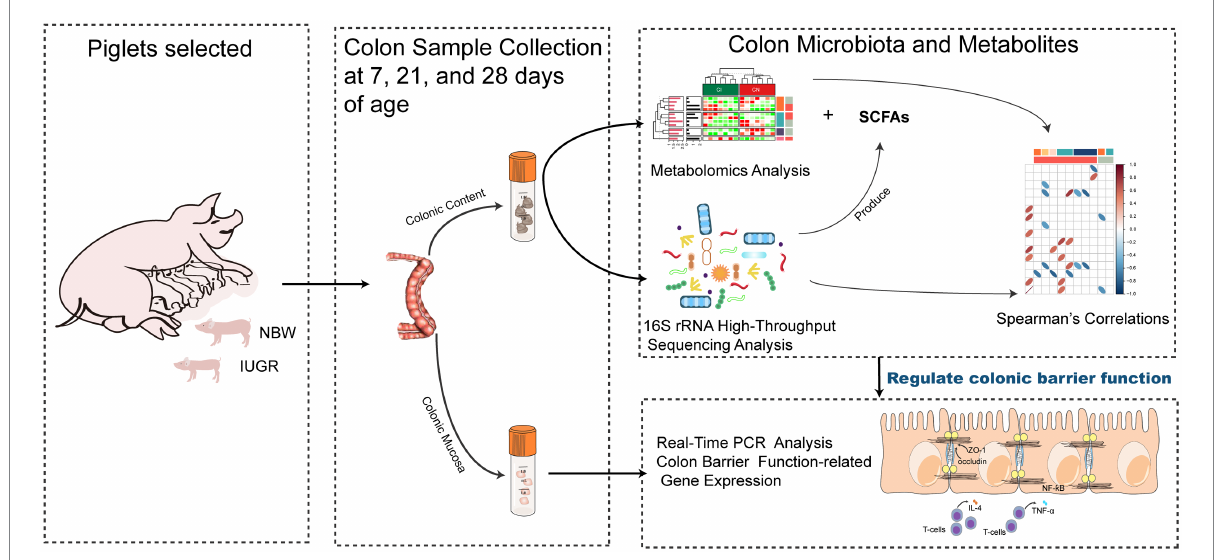
FIGURE 1 Schematic presentation of the overall experimental procedure on metabolome, microbiome, and gene expression alterations in colon of newborn piglets with intrauterine growth